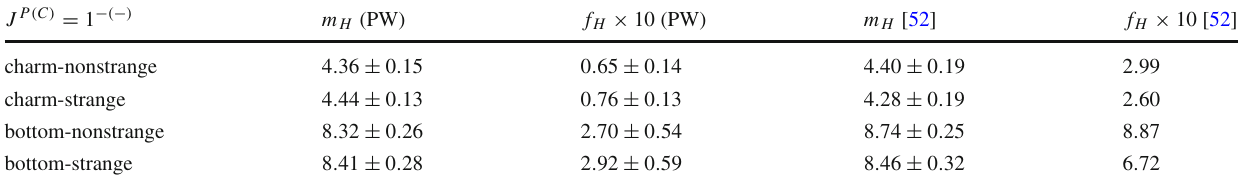
Table 9 Comparison of the values for the mass and current coupling for quantum numbers J P ( C ) = 1 − ( − ) of the different heavy-light hybrid mesons between the present work (PW) and Ref. [52]. The masses are in GeV and the current couplings are in GeV 3